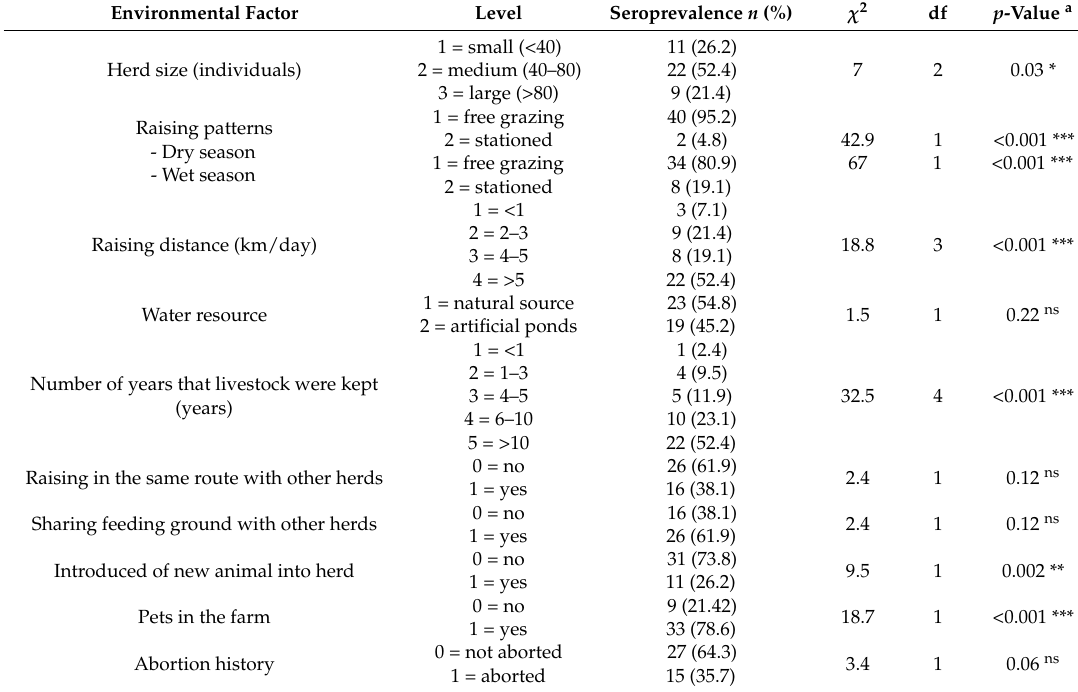
Table 3. The relationships between environmental factors and seroprevalence in domestic cattle in Salakphra Wildlife